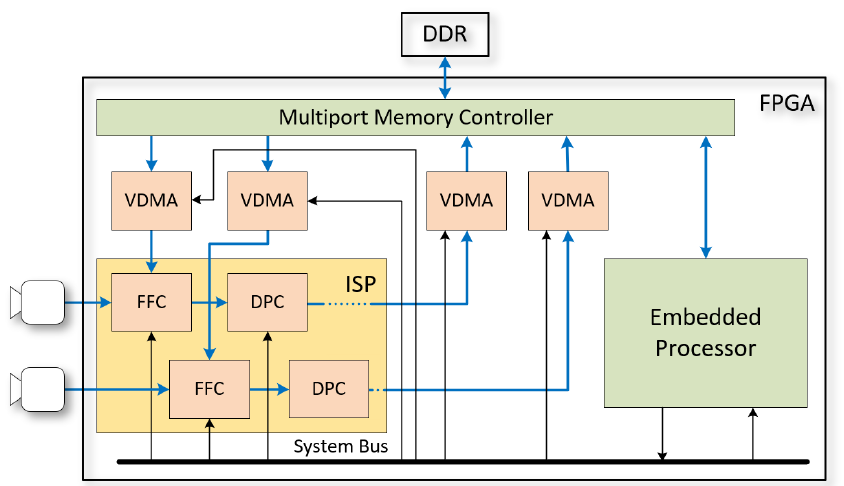
Figure 8. Uniformity correction of stereo